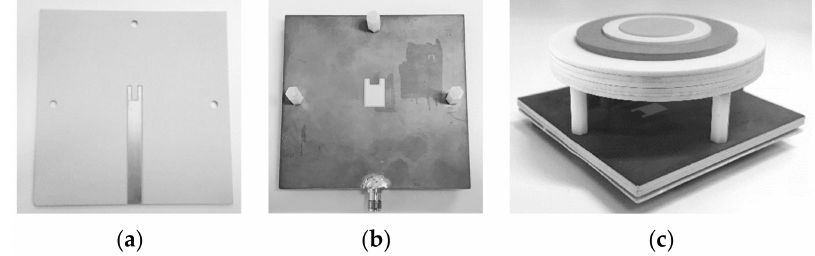
Figure 7. Photograph of fabricated prototype for measurements. ( a ) Back view, ( b ) top view of substrates of planar wideband feed taken apart and ( c ) the assembled RCA